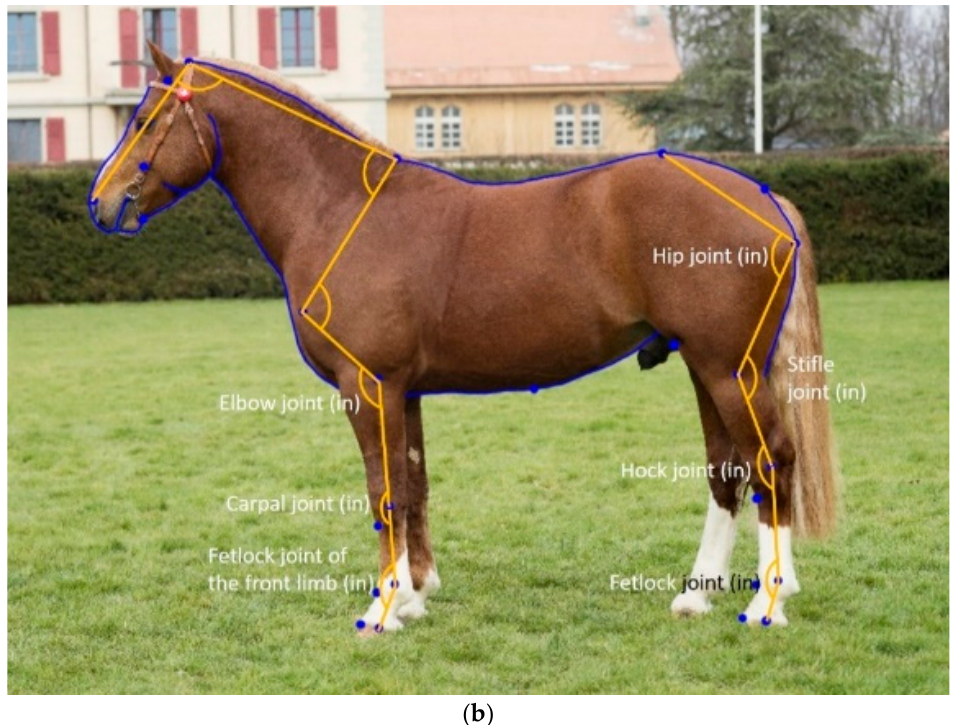
Figure 1. Example of the initial horse shape space model with both curves and angles derived from landmarks ( a ), and the newly proposed landmarks and additional joint angles ( b ).